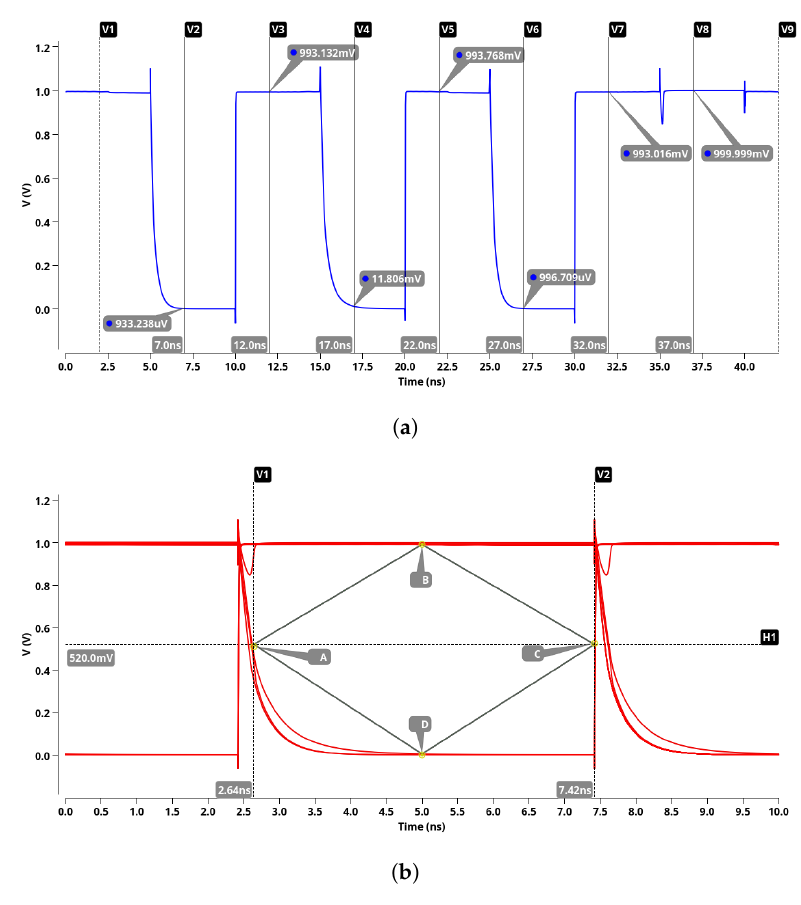
Figure 6. ( a ) Defining UI for the logic-locking block. ( b ) Obtained eye diagram for Case 1. A centered eye-diagram was created as shown in Figure 6b, highlighted in red. The eye period is set to 2 ∗ UI = 10 ns and the threshold is at 520 mV. To evaluate the